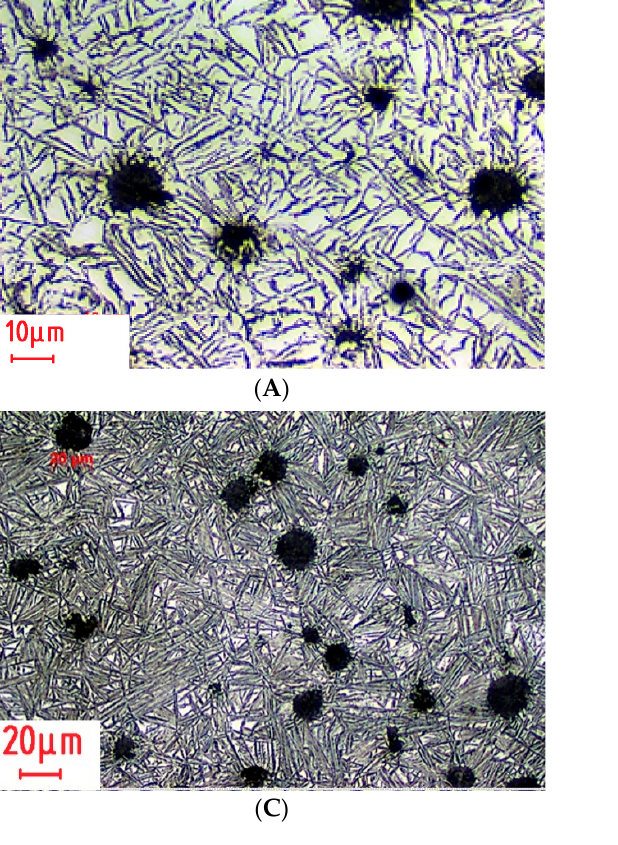
Figure 3. Surface of ADI_310_SP after shot peening (SEM).